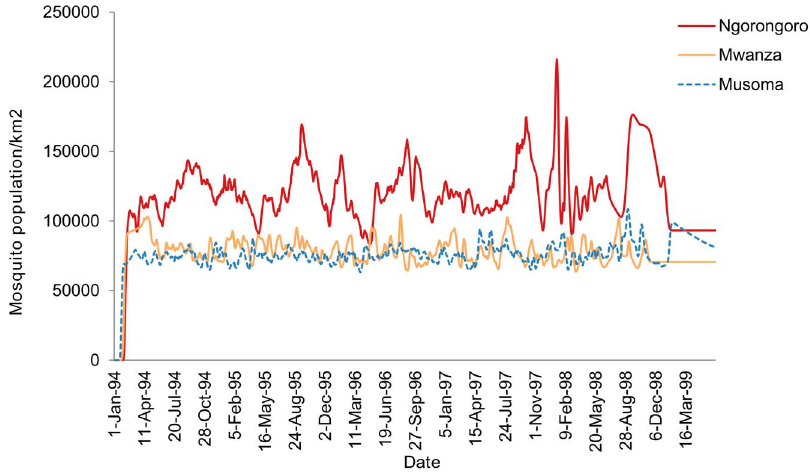
Figure 7. Vector population dynamics simulation results indicating unusual increase in mosquito population in late 1997 and early 1998. Similar period to when large-scale RVF outbreak occurred in Ngorongoro district. Disease outbreak did not occur in Mwanza and Musoma areas during the same period.